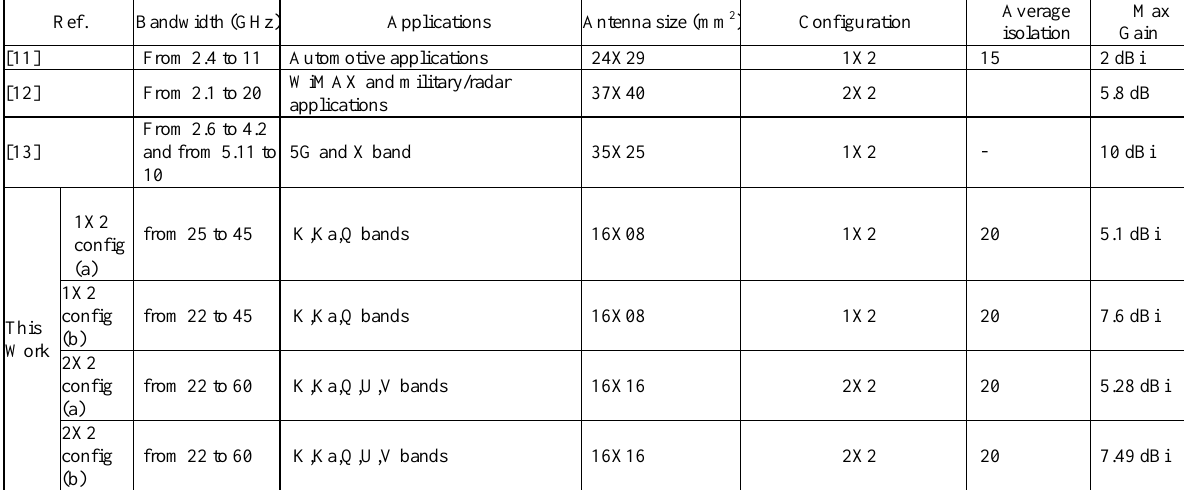
Table 1. Performance comparisons between the proposed and some previously reported MIMO